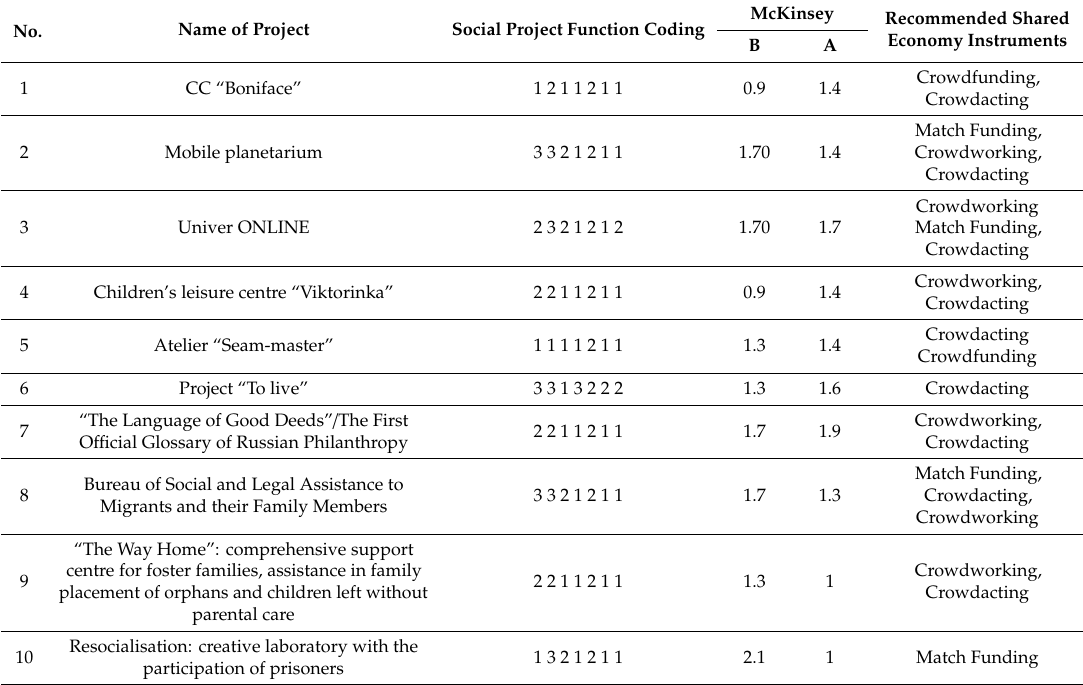
Table 6. Analysis of social